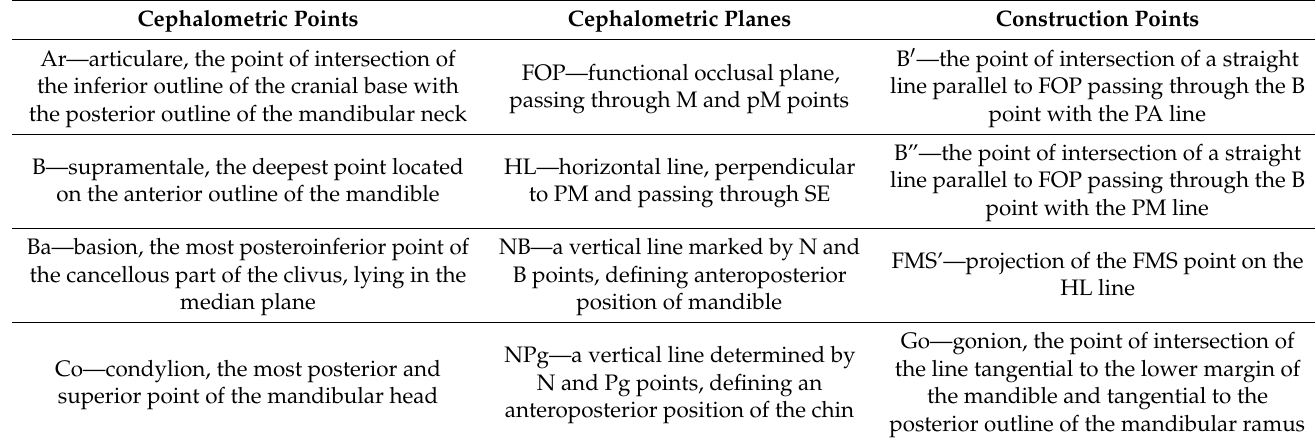
Table 1. Cephalometric points, planes and construction points used in the